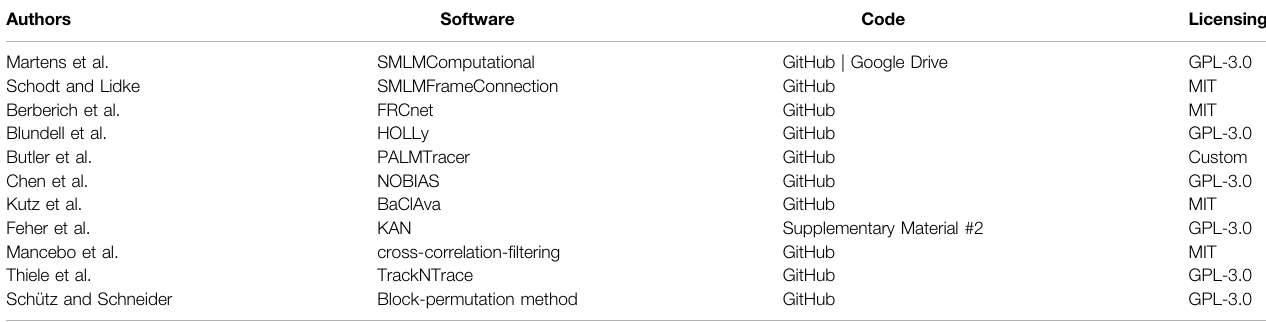
TABLE 1 | Comprehensive list of the software packages mentioned in the manuscripts in this research topic, along with their code availability destination at the time of publishing and public licensing speci fi